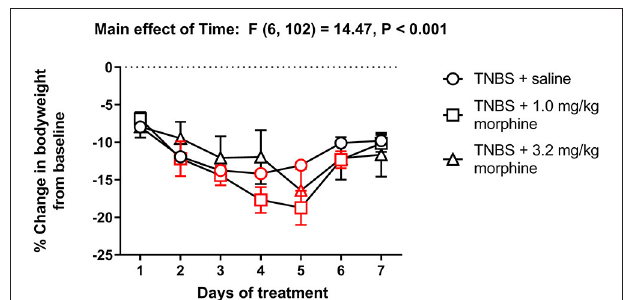
FIGURE 10 | Effect of repeated morphine administration on the body weight of TNBS-treated mice. Percent change in body weight from baseline of TNBS-treated mice injected with saline, 1.0 or 3.2 mg/kg/day morphine s.c. Morphine did not exacerbate weight loss in TNBS-treated mice. Data are mean ± SEM and analyzed by two-way repeated measures ANOVA. TNBS + saline ( N = 8/day); TNBS + 1.0 mg/kg morphine ( N = 6/day); TNBS + 3.2 mg/kg morphine ( N = 6/day). Red points indicate significance ( P < 0.05) vs. day one by repeated measures two-way ANOVA with Dunnett’s test.